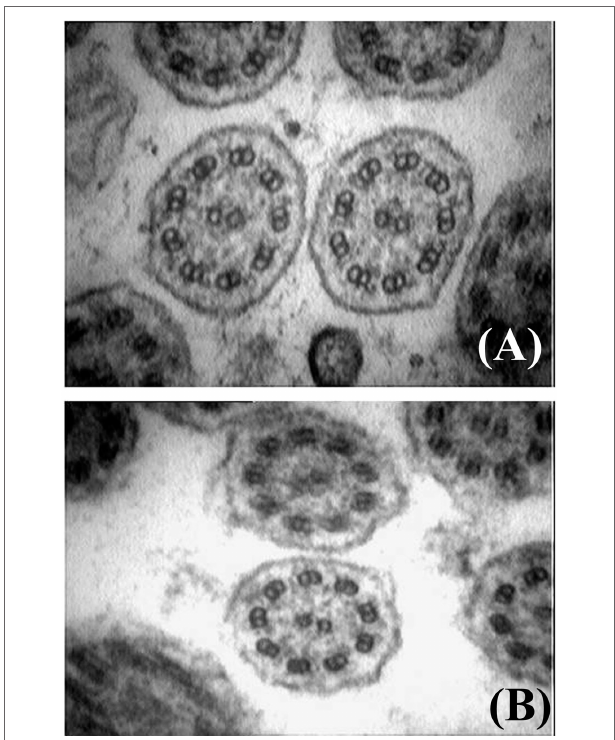
FiGURe 3 | Electron microscopy findings showing normal cilia ultrastructure from an healthy subject (A) , and outer and inner dynein arms defect from a patient with primary ciliary dyskinesia (B) (courtesy of Dr. Mariarosaria Cervasio, Department of Advanced Biomedical Sciences, Anatomo- Pathology Unit, Federico II University, Naples,